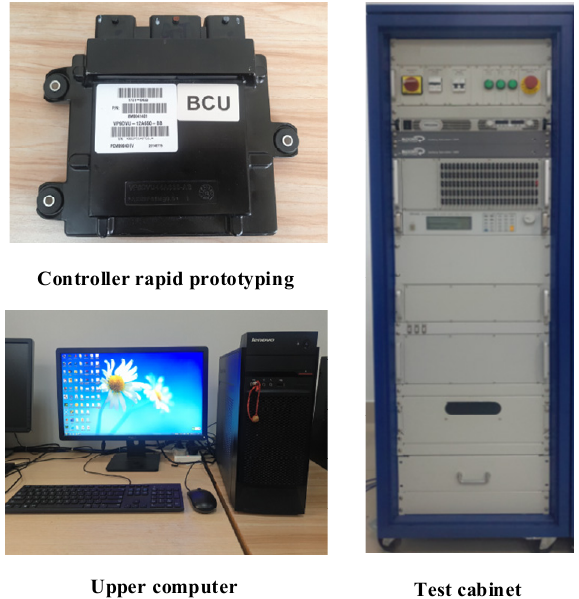
World Electr. Veh. J. 2022 , 13 , x FOR PEER REVIEW Figure 11. Hardware composition of fault-tolerant control HiL test platform for ECAS system.